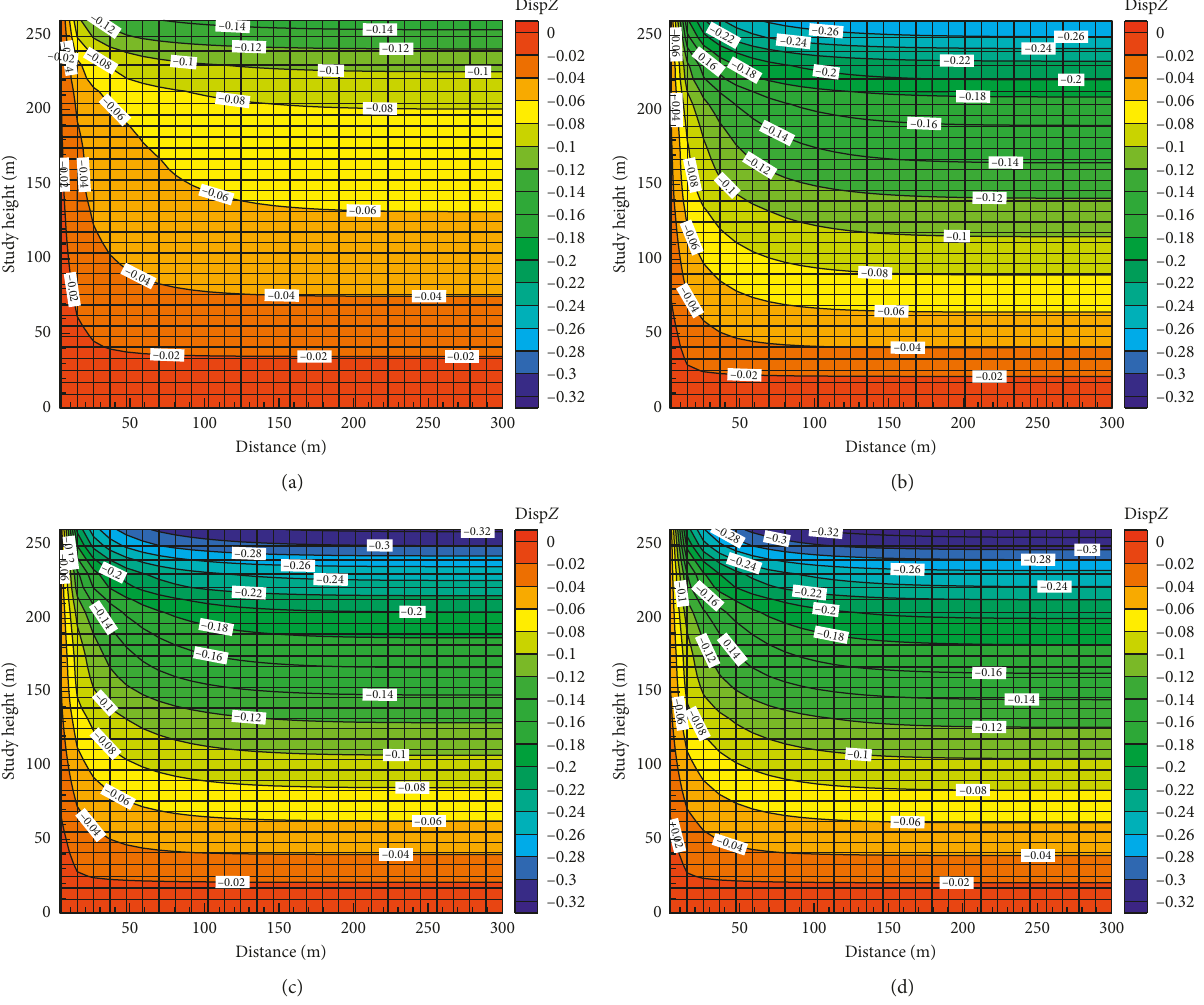
Figure 8: The compression deformation of the formation near the shaft under different load levels: (a) fourth load level; (b) fifth load level; (c) seventh load level; (d) ninth load level.